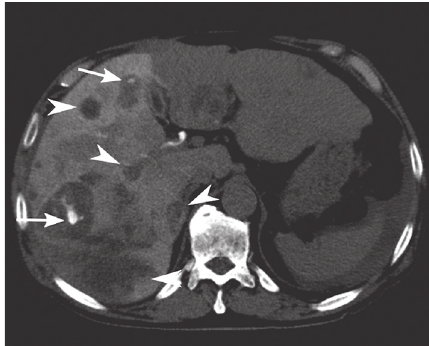
Figure 5: Arterial phase of computed tomography during right hepatic arteriography. Pooling of contrast medium was observed (arrows). Contrast effect of tumors was low (arrowheads) and it was considered to indicate decrease in vascularity of hepatocellular carcinomas.